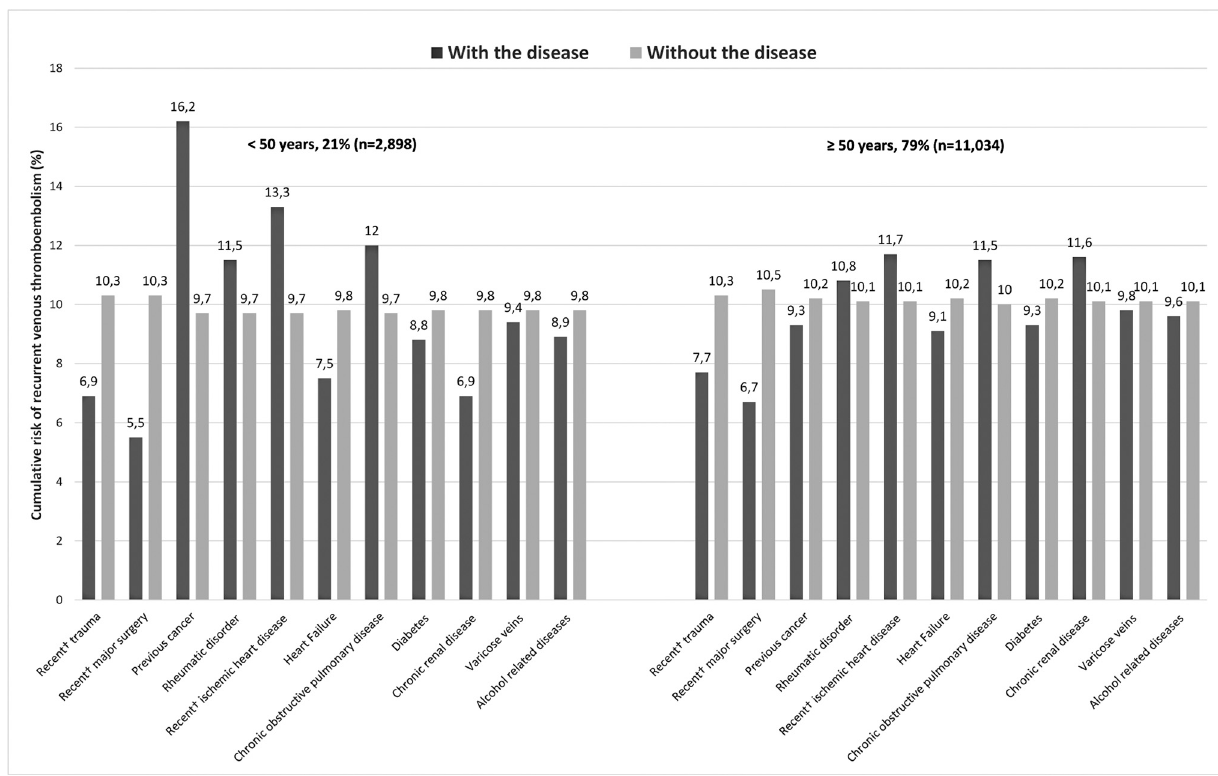
Fig. 2 Cumulative venous thromboembolism recurrence risk for men with and without selected characteristics.